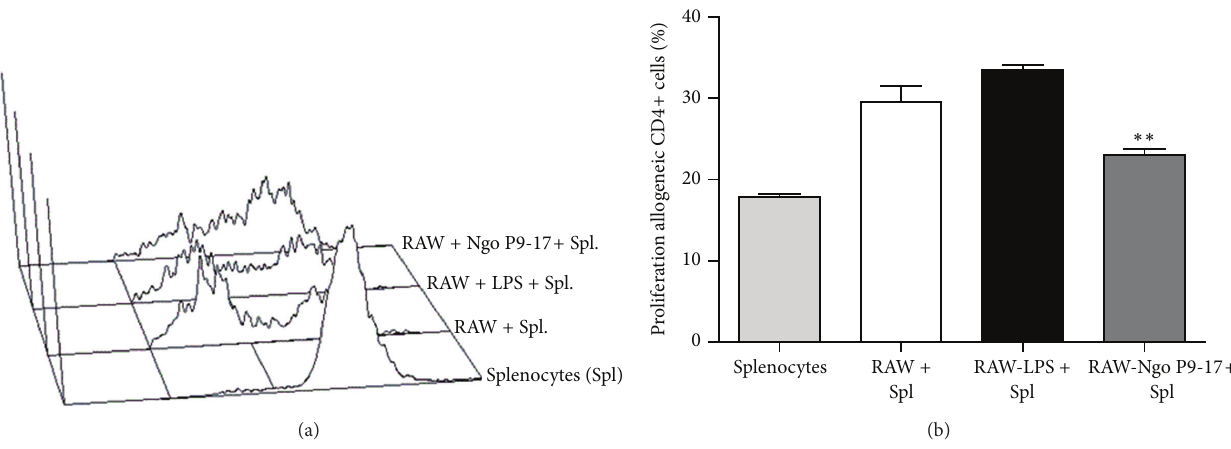
Figure4:HyporesponsivealloantigenT-cellresponsesinducedbyRAWcellsinfectedwith N.gonorrhoeae P9-17.AllogeneicH- 2 b splenocytes were cultured with RAW cells treated with gonococcus, medium and LPS. At day 5, CD4+ T-cell proliferation was determined by CFSE dilution analysis. Representative histogram plots are shown in the upper panel. Percentages of proliferation are indicated in the upper left quadrant. Bars represent mean ± SEM of 5 independent experiments performed in triplicate. ∗∗ indicates that P9-17 induces lower percentages of alloantigen proliferation than LPS and other treatments 𝑃 < 0.01